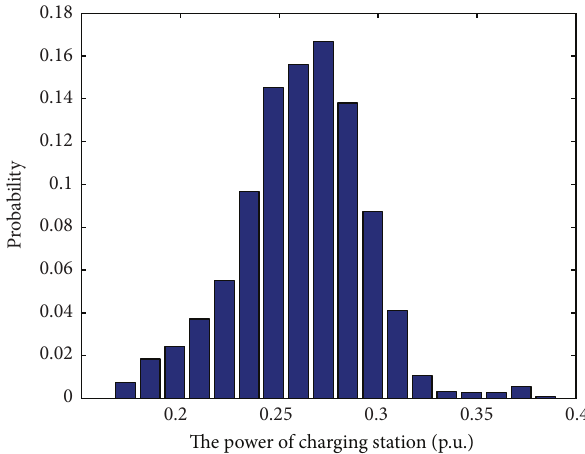
Figure 10: The probability distribution of charging station’s power during